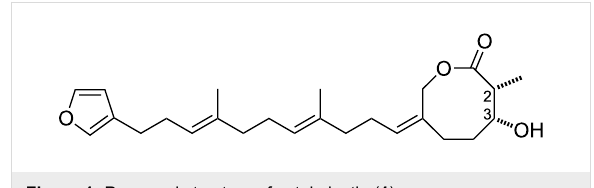
Figure 1: Proposed structure of astakolactin ( 1